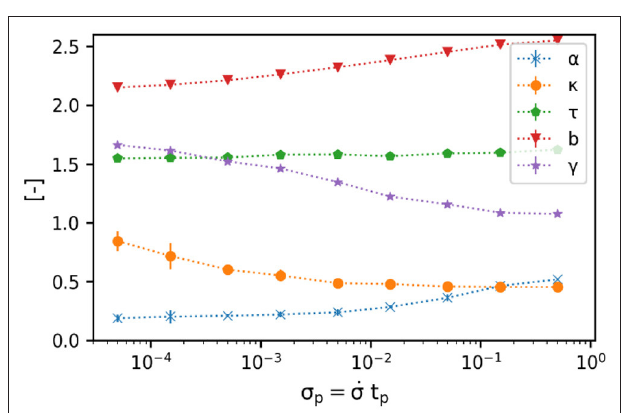
FIGURE 6 | Critical exponents for different increasing healing speeds. The healing speed increases with decreasing healing load σ p = ˙ σ t p